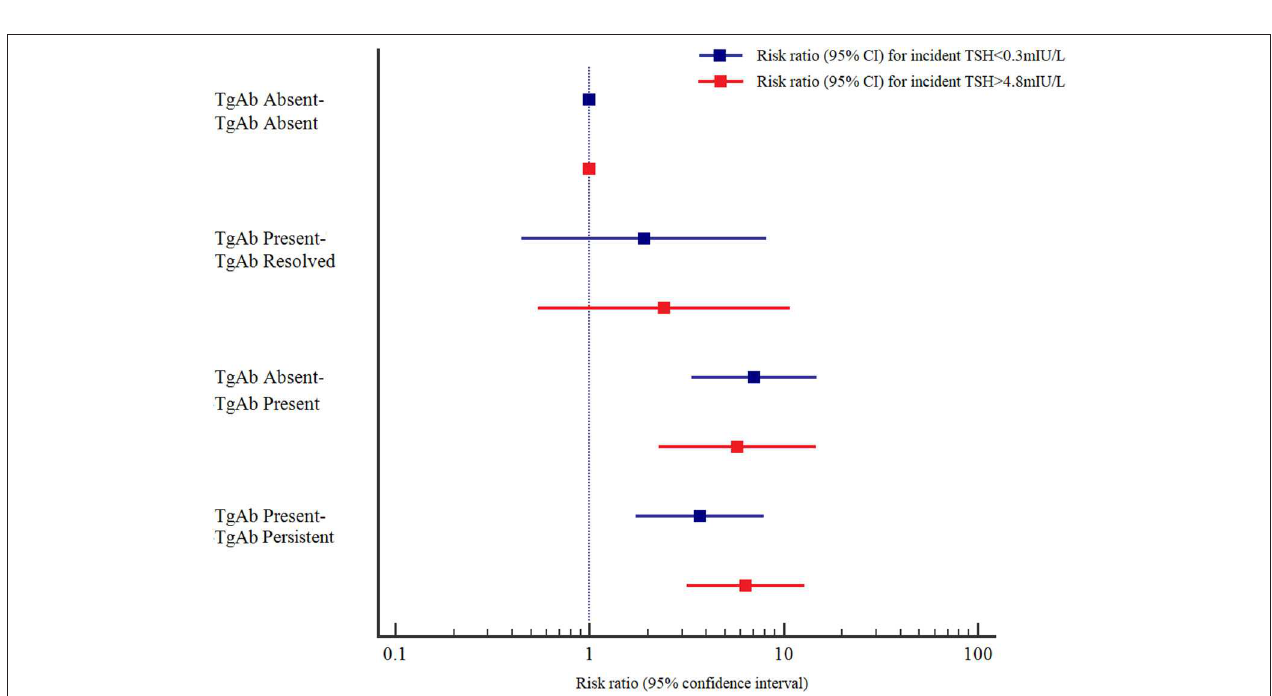
FIGURE 2 | Adjusted risk ratios (RRs) and 95% confidence intervals (95% CIs) for the association of TgAb and abnormal TSH levels by TgAb status at baseline and at follow-up. Adjusted RRs and 95% CIs were adjusted for age, sex, UIC, Tg, and TSH at baseline. plausible mechanism is the potential role played by the amounts of T3 and T4 will eventually run out, inducing TSHr stimulating antibody; however, we could not obtain elevated TSH. Therefore, positive thyroid antibodies indicate data for thyrotrophin receptor antibody (TRAb). Thus, the a symptom of immune dysfunction in humans. Another